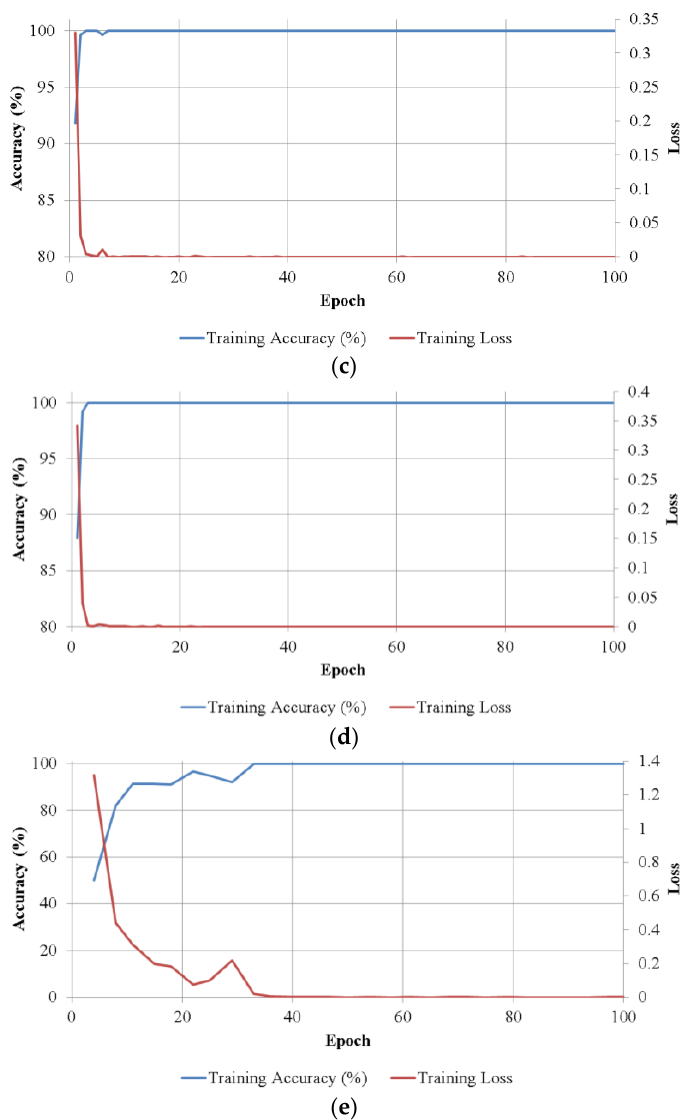
Figure 8. Convergence graphs with average accuracies and losses according to the number of training epochs on two trainings of two-fold cross-validation on the five size classes: ( a ) 1st size class; ( b ) 2nd size class; ( c ) 3rd size class; ( d ) 4th size class; and ( e ) 5th size class.